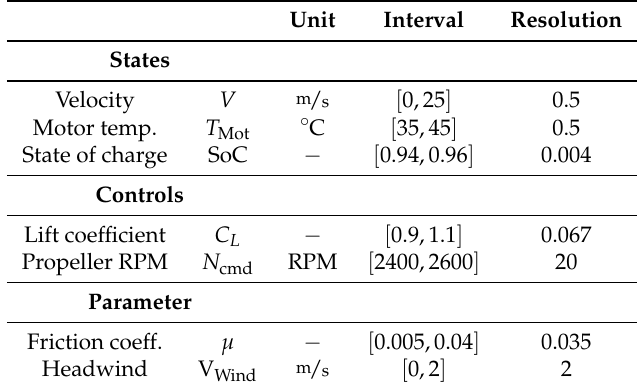
Table 2. Ranges of the states, controls and the parameter assumed for the construction of the discrete